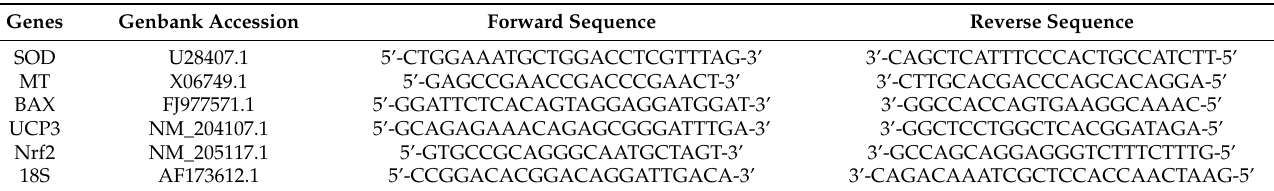
Table 2. Primers used for the target and reference.